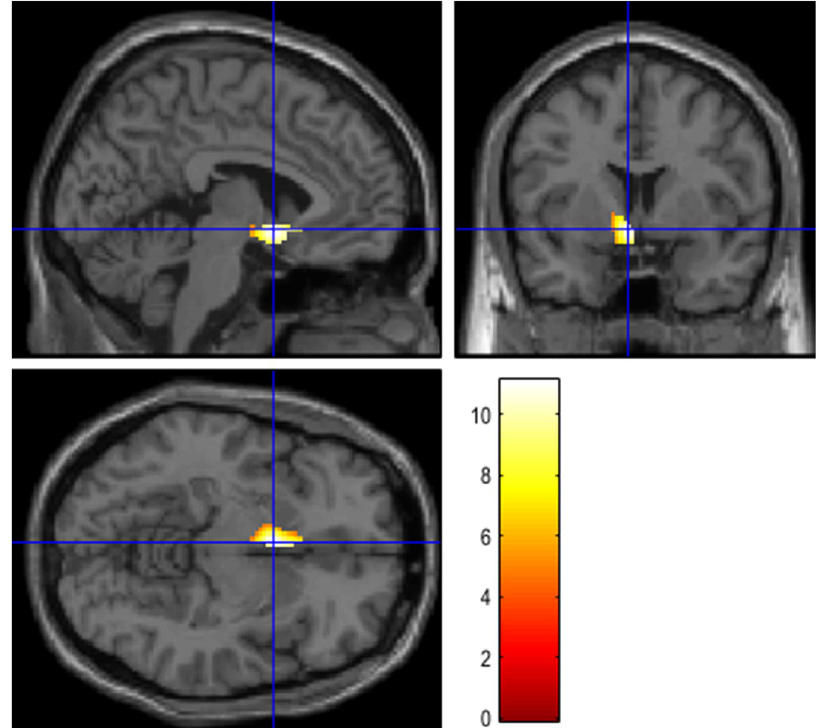
Figure 2. T1 magnetic resonance imaging superimposition showing the significant (positive) relationship between cortical activity in BA25 and that of the region corresponding to the hypothalamus. Since cluster was large as compared to the anatomical region here represented, for illustrative purposes a mask with WFU pickatlas was generated. Coordinates are shown in Table 4.